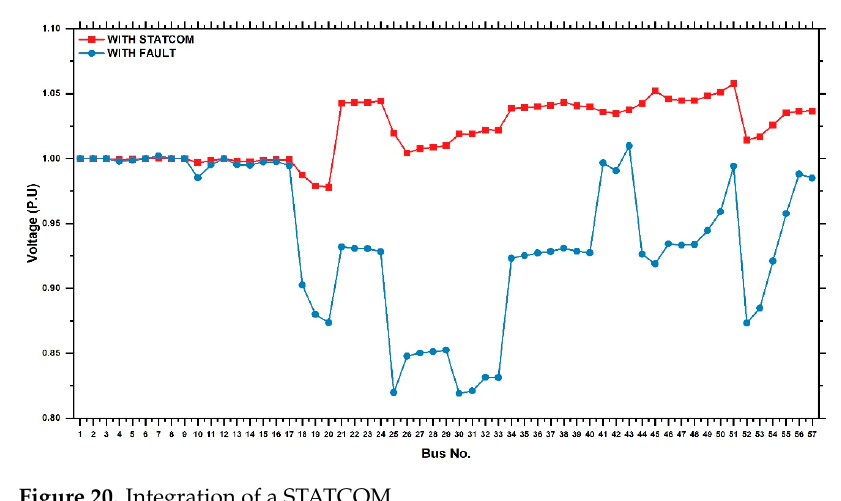
Figure 20. Integration of a STATCOM.